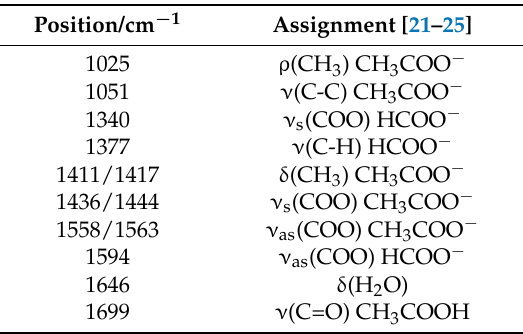
Table 2. Vibrational frequencies and mode assignments of the observed FTIR bands (cm − 1 ) during the acetaldehyde treatment of an anatase film, upon UV